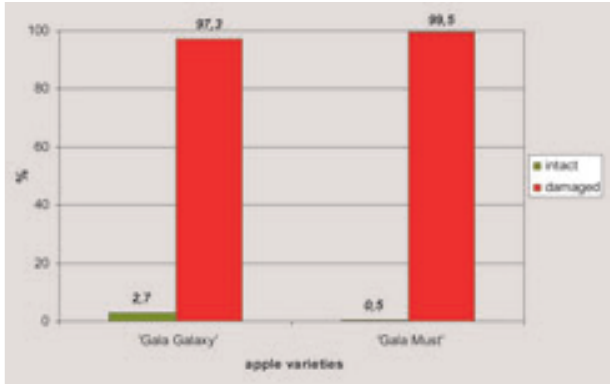
Figure 5 . Damage caused by hail outside the hail protection net ( Debrecen- Pallag, 2011)